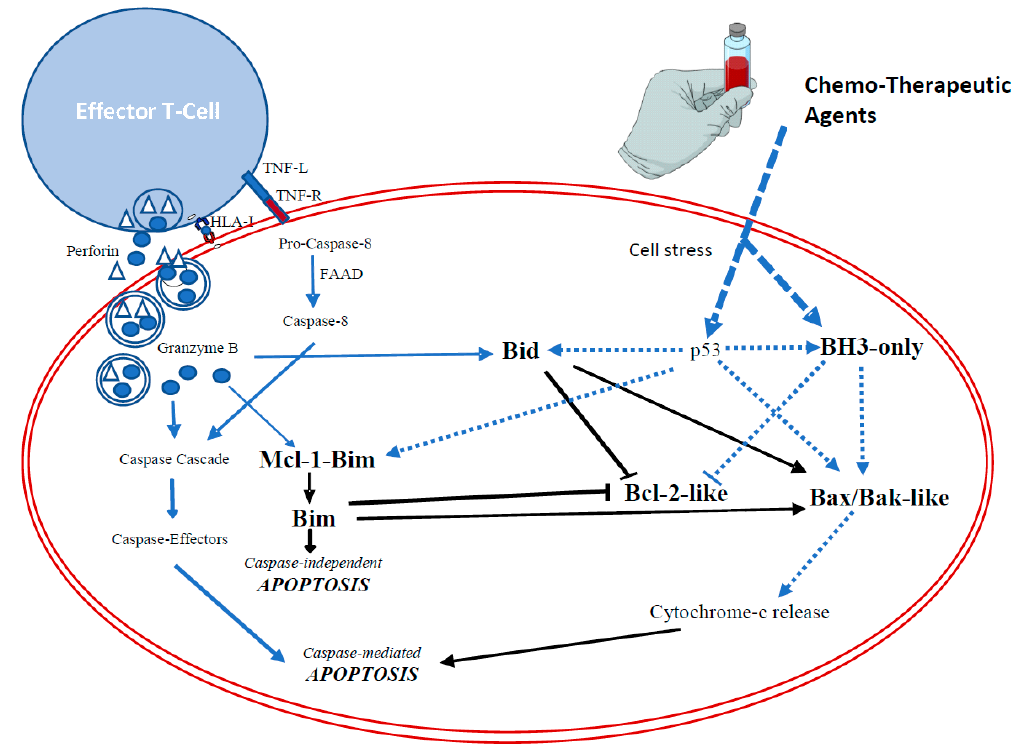
Figure 4. Apoptosis pathways mediated by chemo- and immunotherapy. Both chemo- and immunotherapy converge on common pathways (black lines) in which pro-apoptotic Bid and Bim play a key role as connecting elements. Cell death induced by chemotherapy (blue dotted line): Cell stress caused by chemotherapy entails the activation of p53 and BH3-only-proteins. As a result, proapoptotic Bid, Bim and Bax/Bak-like proteins are activated and anti-apoptotic Bcl-2-like proteins inhibited. Cell death induced by immunotherapy (blue solid line): T lymphocytes can trigger cell death by directly activating caspase cascade and by activating caspase-independent apoptosis mediated by Bim as well. This cytotoxic effect is also enhanced by activating pro-apoptotic Bid.